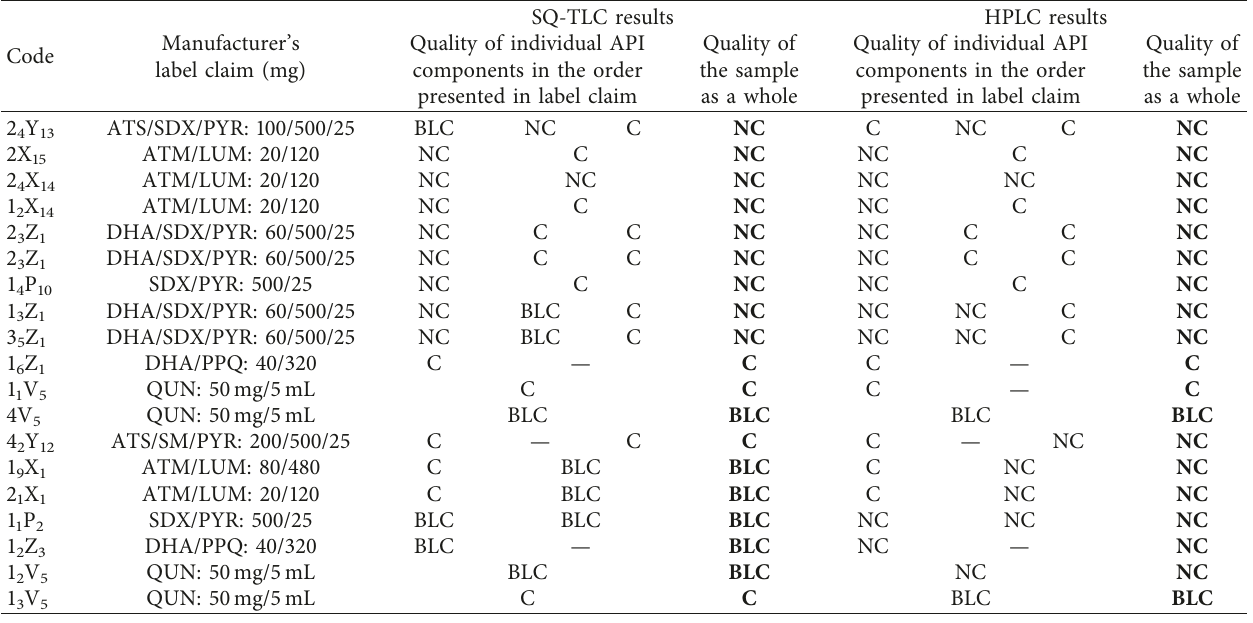
Table 4: Comparison of quality of some antimalarial medicines by SQ-TLC and HPLC. Code